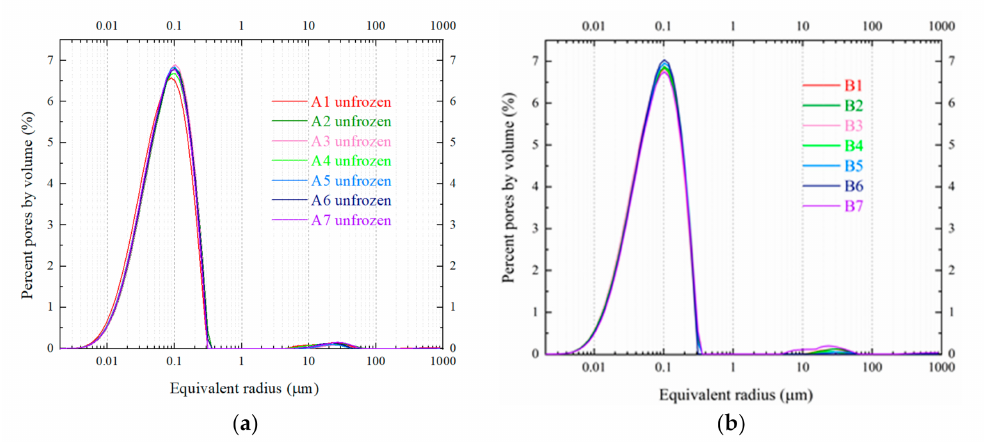
Figure 3. Uniformity of soft clay sample before freezing: ( a ) shows the data for the freezing duration tests and ( b ) shows the data for the gap time tests.